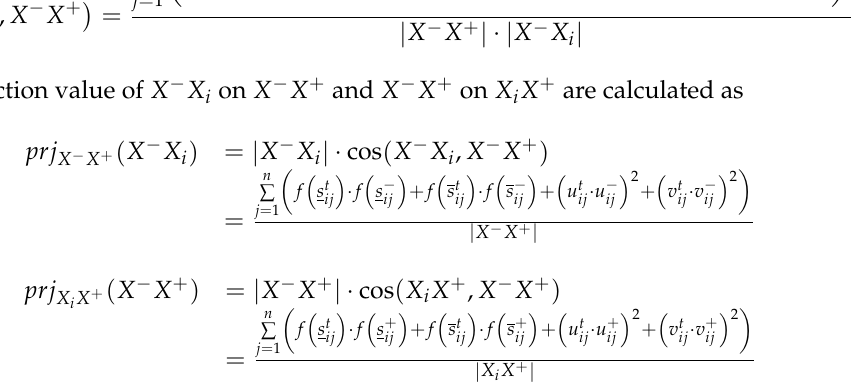
Figure 1. The graphical representation of